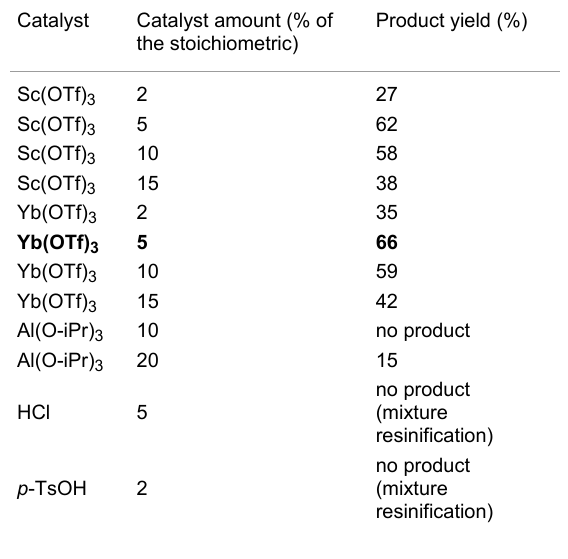
Table 2: Optimization of the reaction conditions for heterocycle 6a syn- thesis. Catalyst